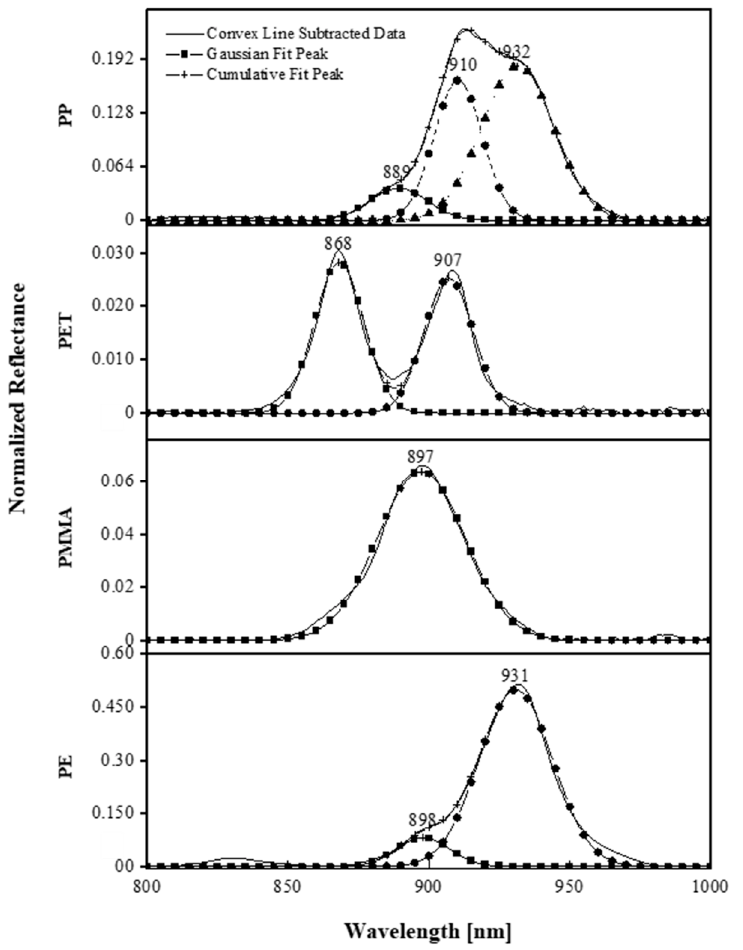
Figure 5. The normalized reflectance of the PP, PET, PMMA, and PE, which shows the characteris- tic peaks of the material and the core components of the Gaussian functions of plastic polymers ( λ p : Gaussian peak wavelength, NR max : maximum of normalized reflectance, FWHM: full-width half maximum with a unit of nm )